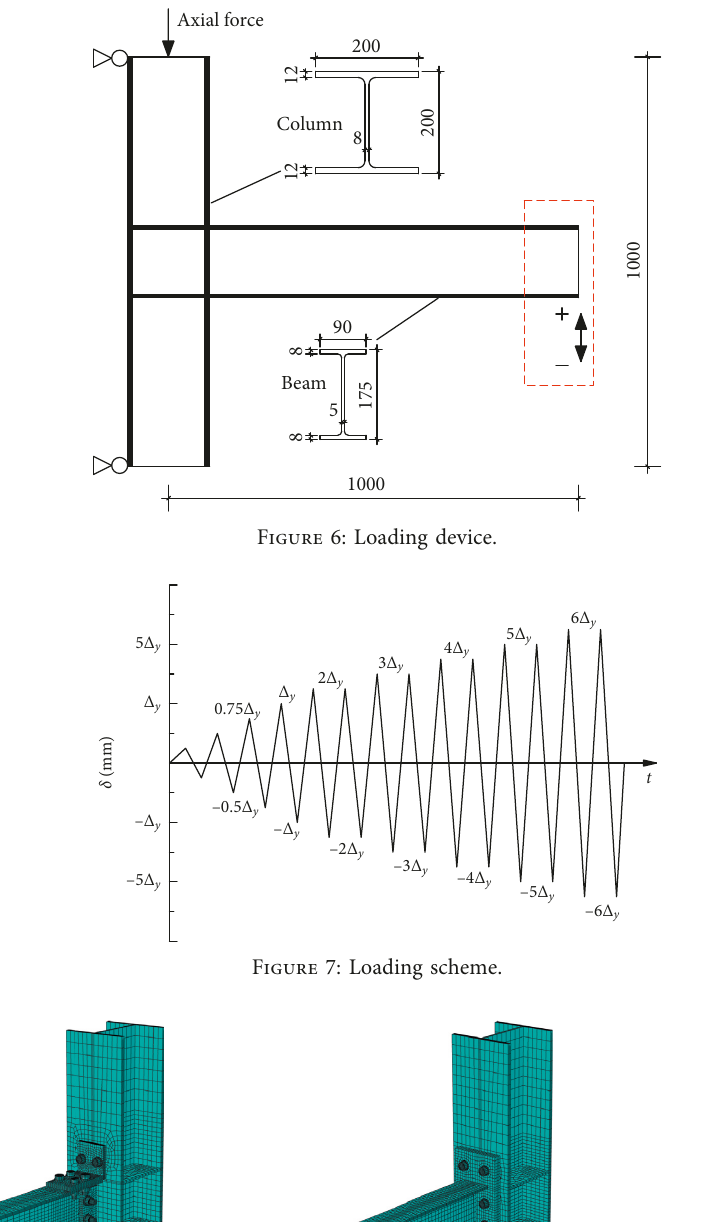
Figure 8: Finite element models of the joints. (a) J-1. (b) J-2. (c)